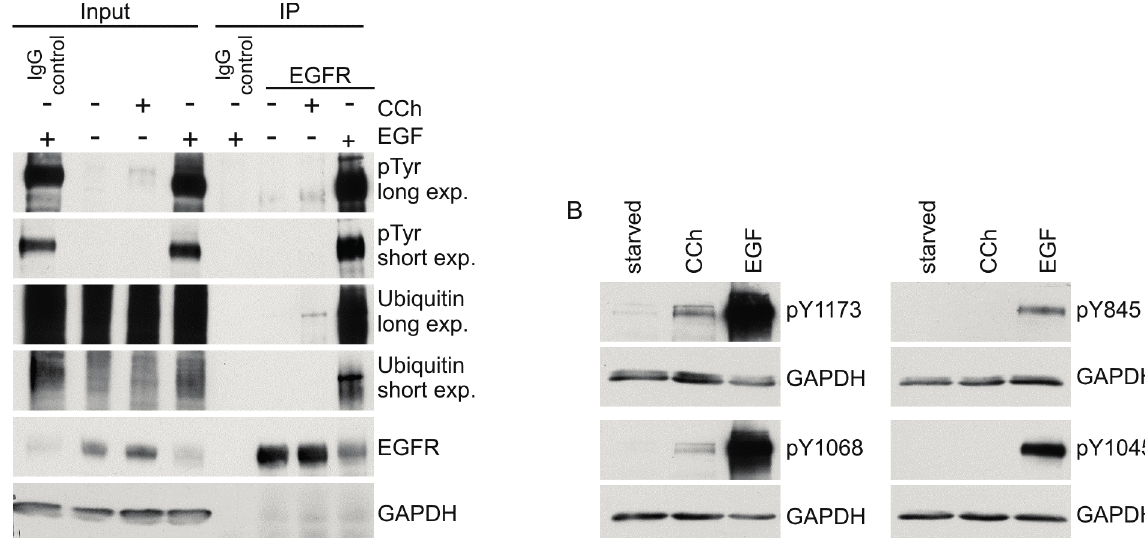
Figure 5. CCh treatment leads to a lower degree of phosphorylation and ubiquitination of the EGFR than EGF treatment. Serum-starved HaCaT cells were stimulated with 1 mM CCh or 16 nM EGF for 15 min ( A ) or 30 min ( B ). ( A ) The cells were lysed and EGFR was immunoprecipitated. The samples were separated by SDS-PAGE and immunoblotted for phospho-Tyr, ubiquitin and EGFR; ( B ) Equal amounts of cell lysates were separated by SDS-PAGE, immunoblotted and probed with anti phospho-Tyr antibodies specific for the indicated EGFR phosphorylation sites. The blots shown are representative of three independent